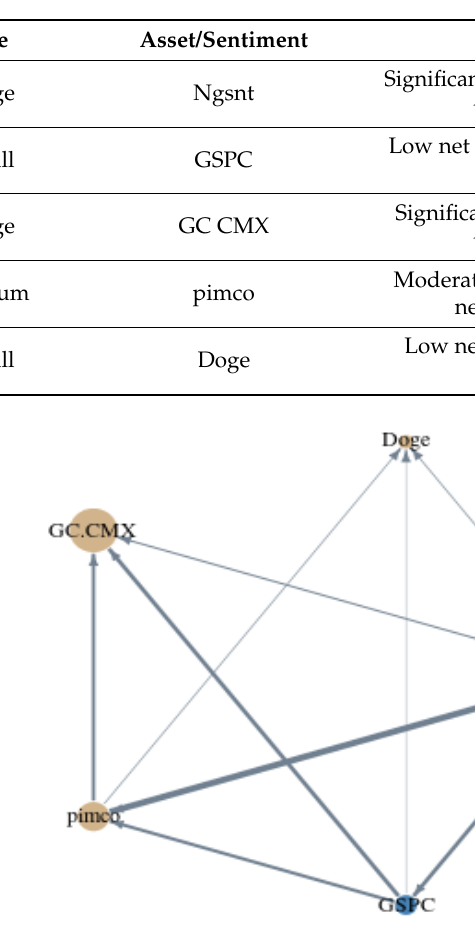
Table 5. Network connectedness table (showcasing net emitters/receivers).